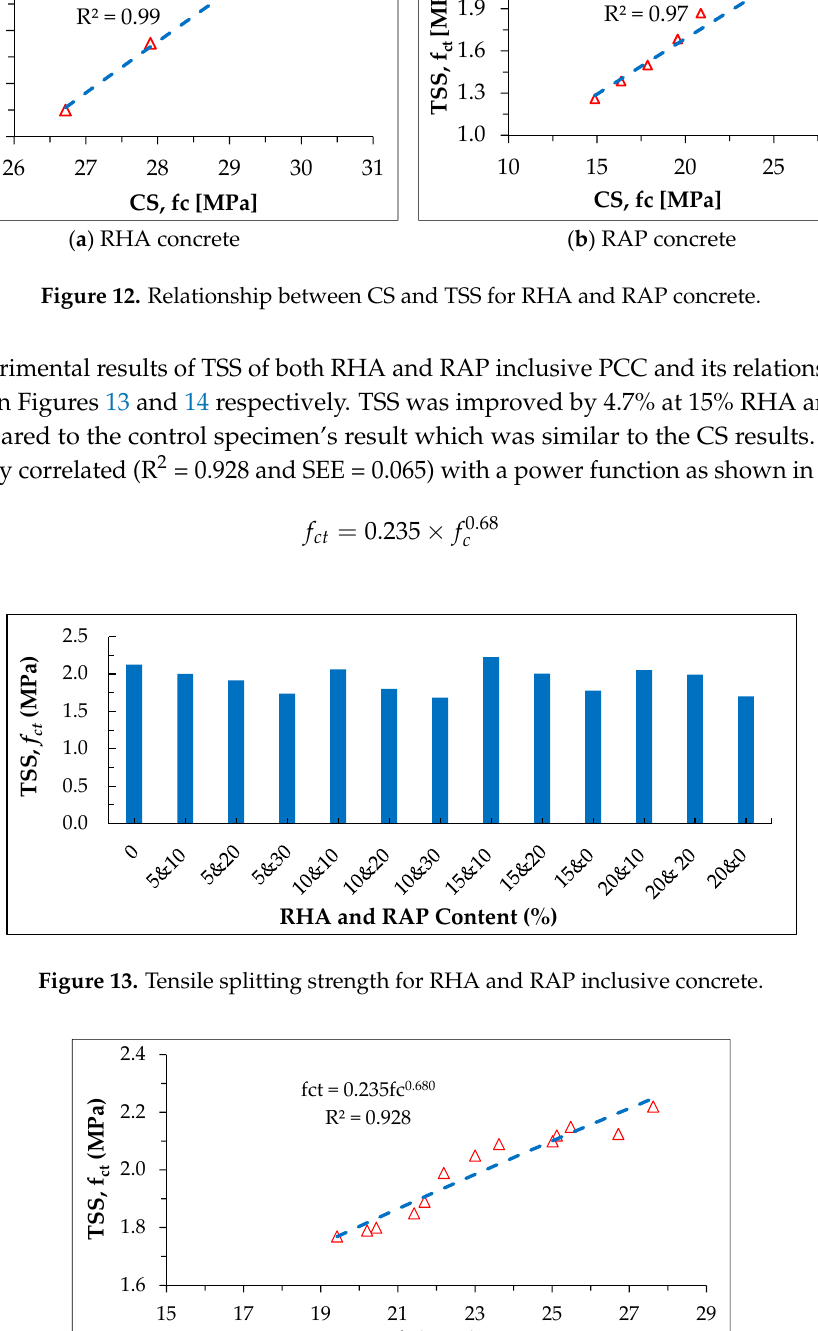
Figure 14. Relationship between TSS and CS for RHA and RAP inclusive concrete.